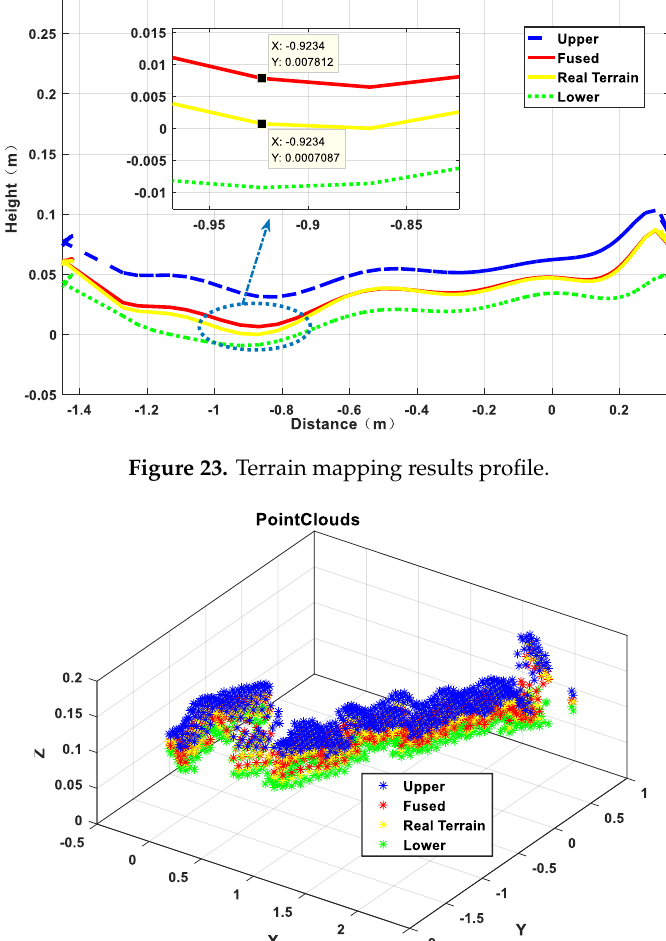
Figure 24. Terrain mapping 3D point clouds.